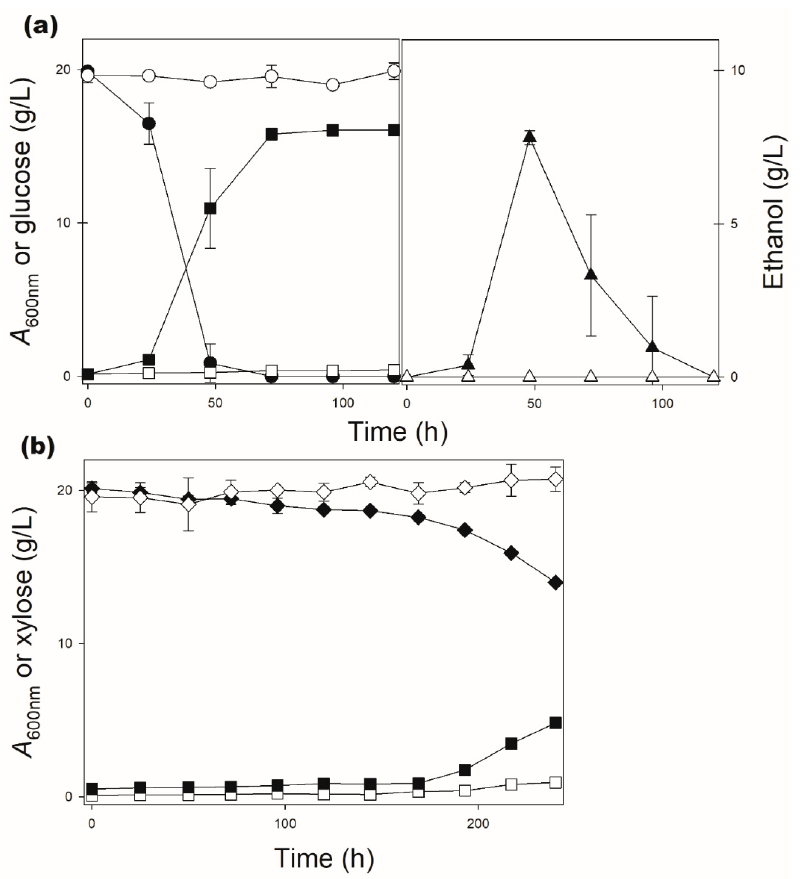
Figure 2. Aerobic growth of strain DLG-K1 transformed with plasmid pPGK- SpXUT1 (open symbols) or plasmid pPGK- SpXUT1 ∆ C (black symbols) in YNB medium (lacking uracil) containing 2% glucose ( a ) or xylose ( b ) as carbon source, at 30 ◦ C. At the indicated time points, the cell growth (squares), glucose (circles), xylose (diamonds) and ethanol (triangles) concentrations were determined. No ethanol was produced during xylose